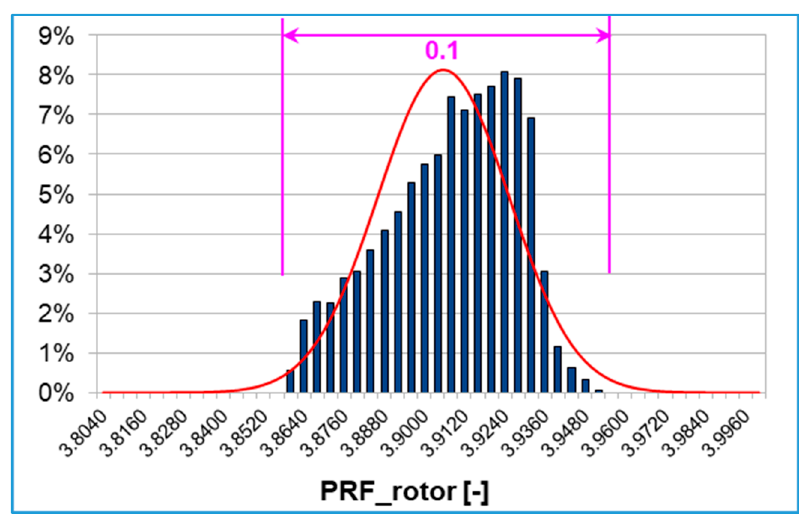
Figure 10. SB-UQ: rotor pressure ratio probability bars (blue) and related Gaussian trend (red line).